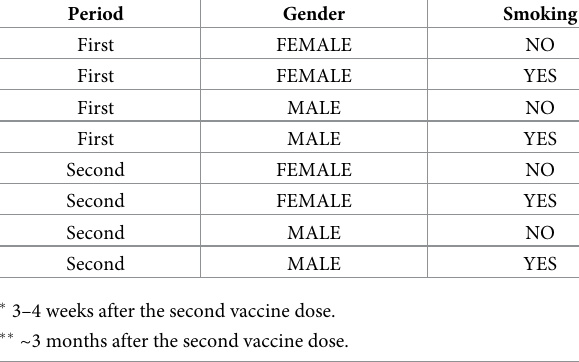
period and gender category) by paired t-tests of all age category combinations, bootstrapping the paired variables 10,000 times. The results of this analysis are summarized in Table 5. In the first period, the antibody titers of females declined with age up to 50 years from a maximum of 76,646 among the 21–30 years-old, and then increased again in the 51–60 and 61–72 age groups (S2 Table). Our contrasts analysis showed significant differences to exist among females between the 21–30 (youngest) and the 31–40, 41–50 and 51–60 age groups, but not between the 21–30 and the 61–72 group (76,646 vs . 63,466, Tables 3 and 4). In the second sampling period there were no statistically significant differences between the age groups of females. No other significant associations were found between the rest of the age categories of female participants in both periods. Table 4. Mean anti-S-RBD IgG antibody titers by gender and smoking during the two study periods.